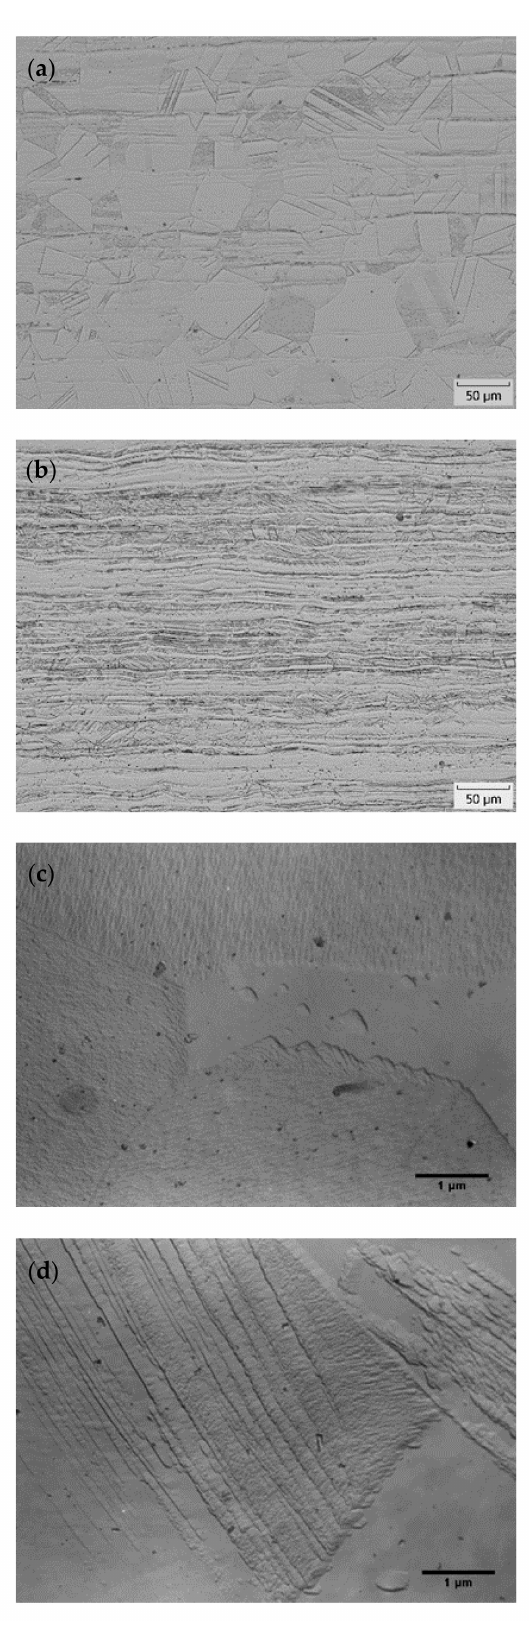
Figure 1. Microstructures of AISI 316L: ( a ) AISI 316L (0% CW)—light microscopy; ( b ) AISI 316L (40% CW)—light microscopy; ( c ) AISI 316L (0% CW)—TEM of a carbon replica; ( d ) AISI 316L (40% CW)—TEM of a carbon